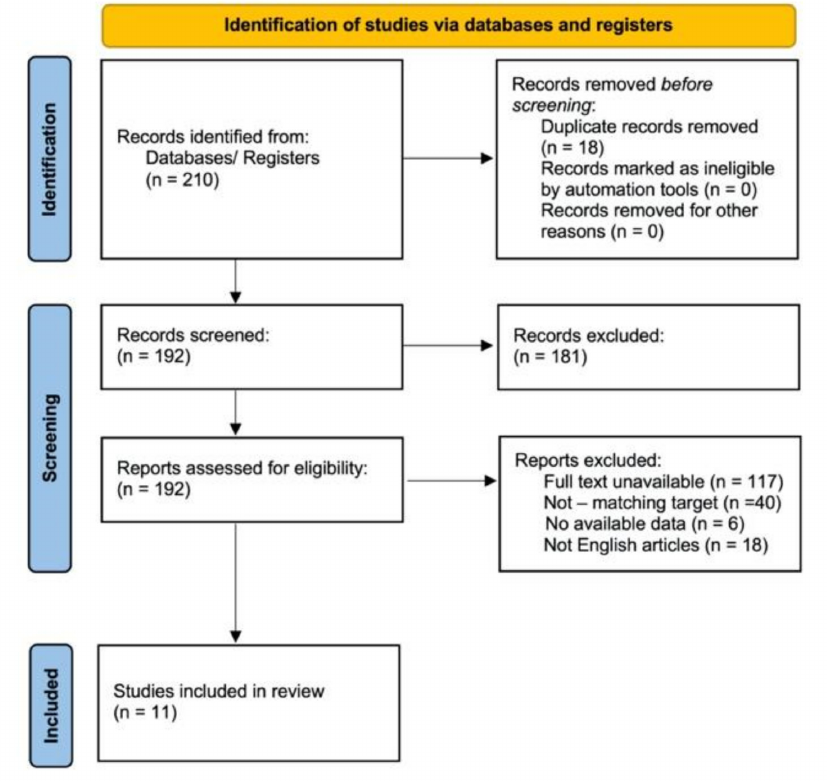
Figure 1. PRISMA flow